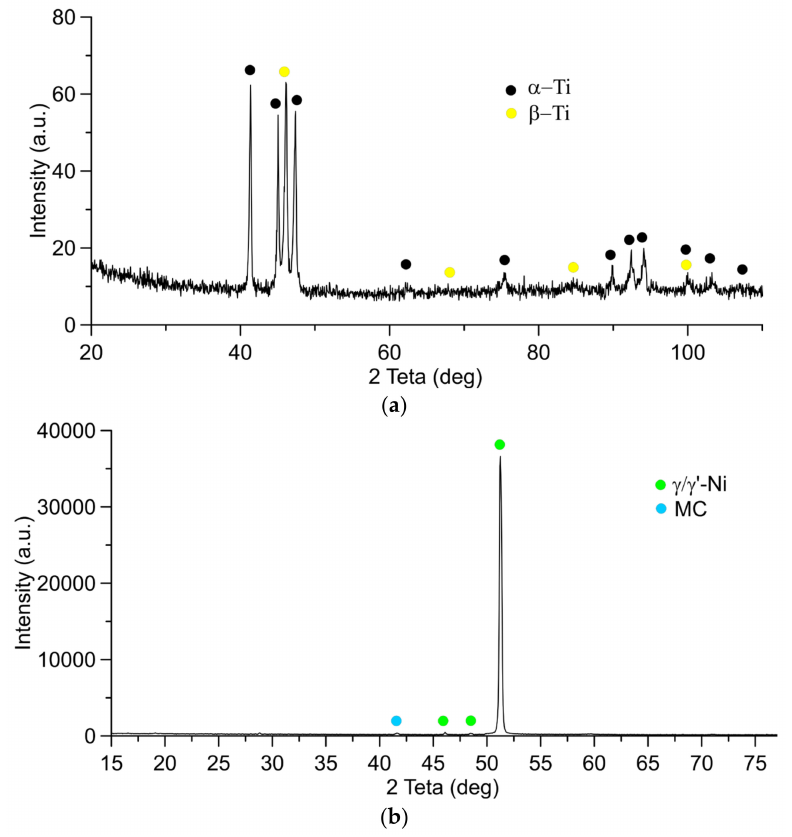
Figure 4. The X-ray diffraction patterns of the basic Ti-6Al-4V alloy ( a ) and nickel superalloy ( b